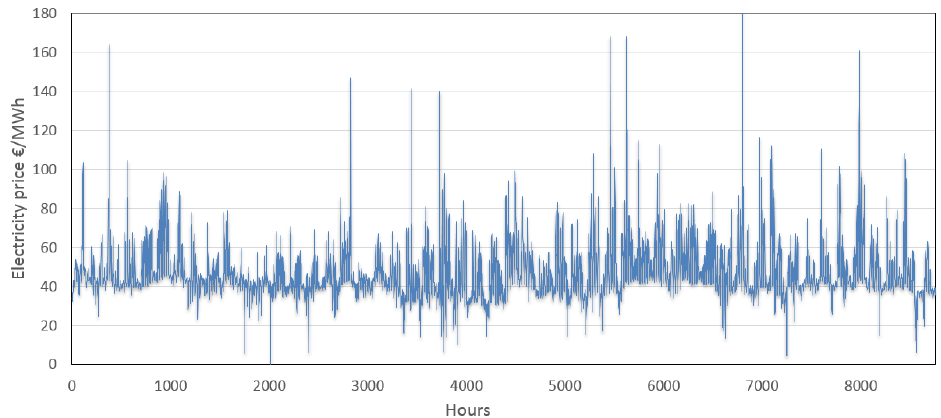
Figure 2. The heat demand of the full Helsinki Metropolitan region [11,60].